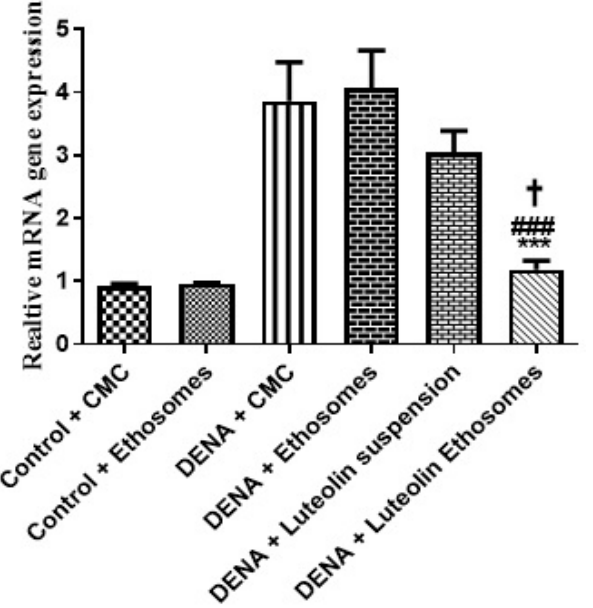
Figure 7. Effects of LUT and/or LUT-ENPs on gene expression of GPC3. Data are presented as mean ± SEM ( n = 12). *, #, and † indicate significant changes from control, DENA, and DENA+ luteolin suspension groups, respectively. † indicates significant change at p < 0.05; *** and ### indicate significant change at p < 0.001.